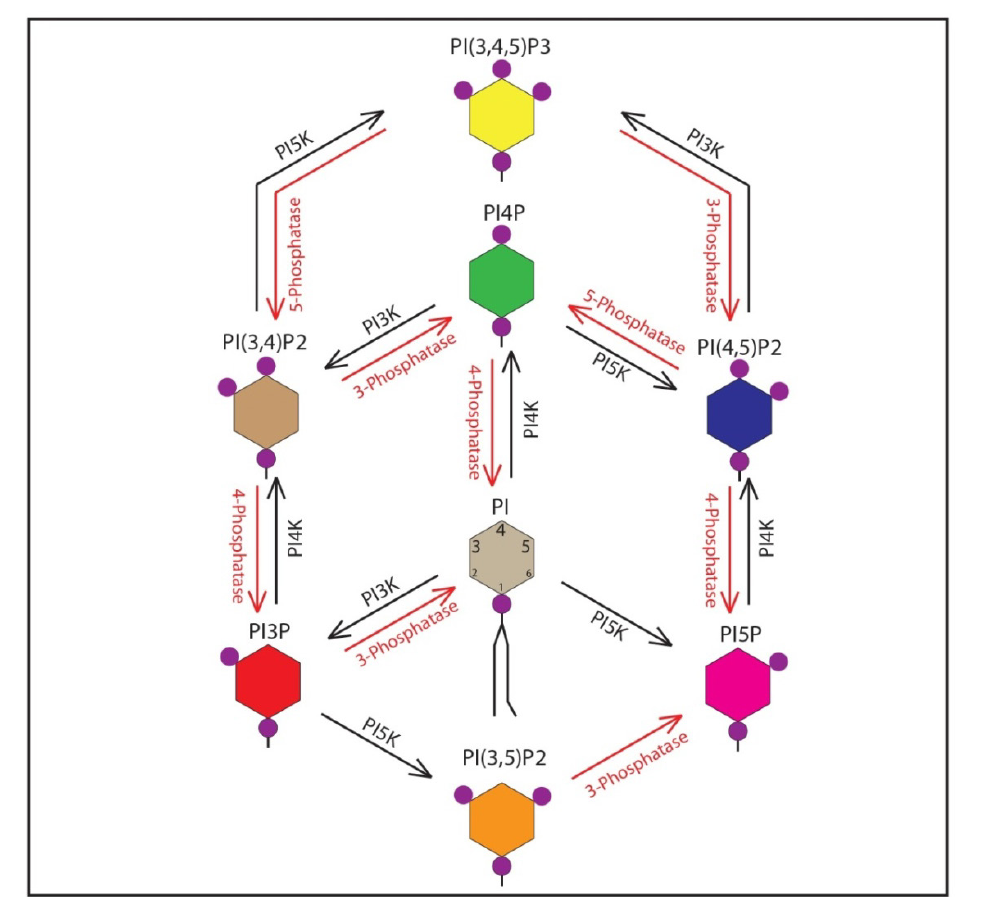
Figure 1. Phosphoinositides (PIPs), Kinases and Phosphatases. Schematic representation of phosphatidylinositol, the seven PIP varieties, kinases and phosphatases involved. Kinases are represented in black, phosphatases in